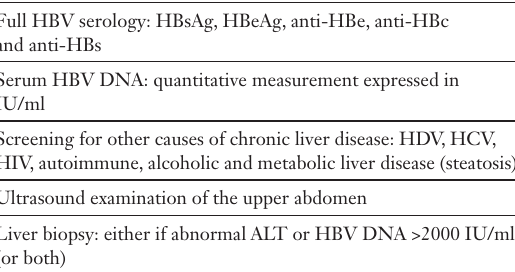
Pre-treatment assessment of liver disease.